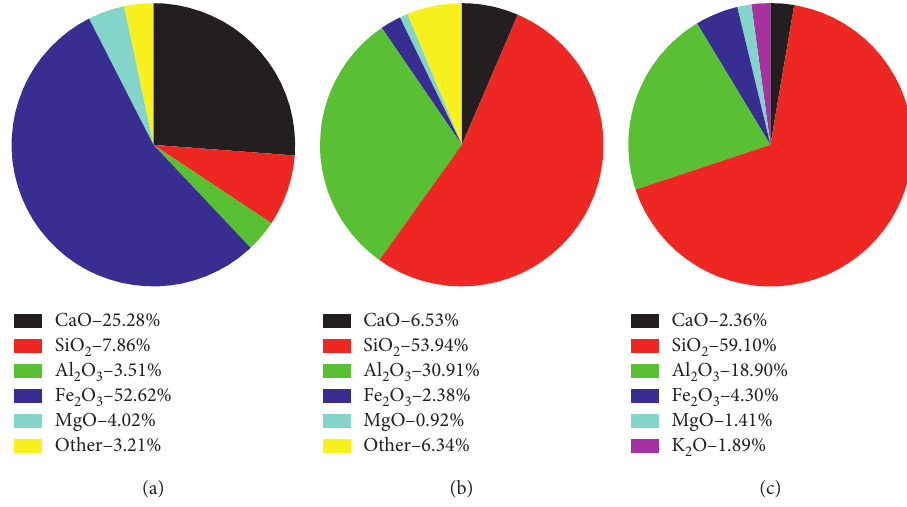
Figure 1: Chemical compositions of raw materials: (a) cement, (b) fly ash, and (c) coal gangue.